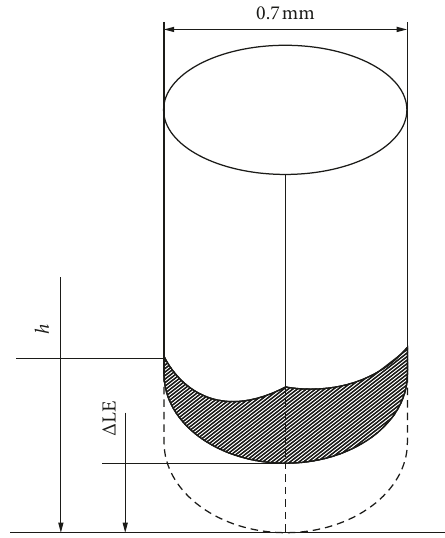
Figure 5: Calculation diagram of the tool wear